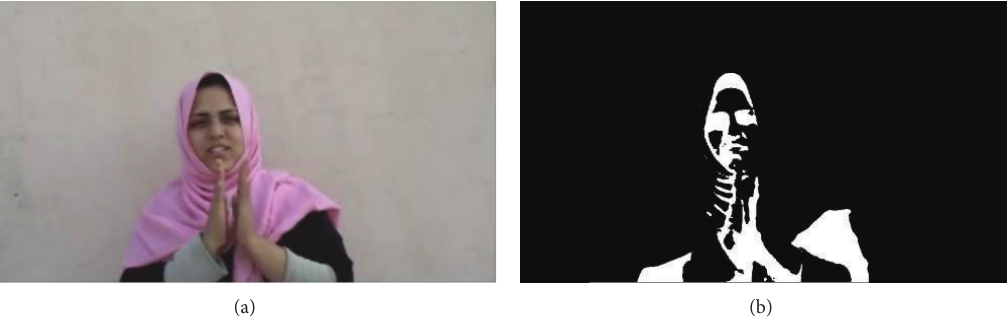
Figure 3: (a) The original frame. (b) The frame after.